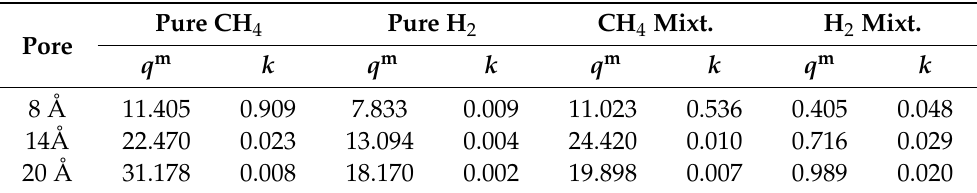
Table 3. Parameters for a fitted Langmuir isotherm against the calculated values from Figure 2. q m in mmol cm − 3 and k in atm − 1